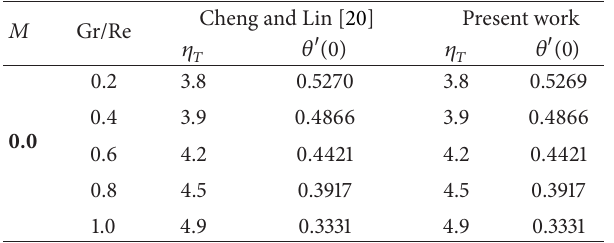
Table 2: Comparison of present results with values obtained by Cheng and Lin [20] for the melting strength 𝑀 = 0.0, 𝑁 = 0 , Df = 0, Sr=0,andLe=1.0inthemixedconvectivestrengthfortheopposing external flow.